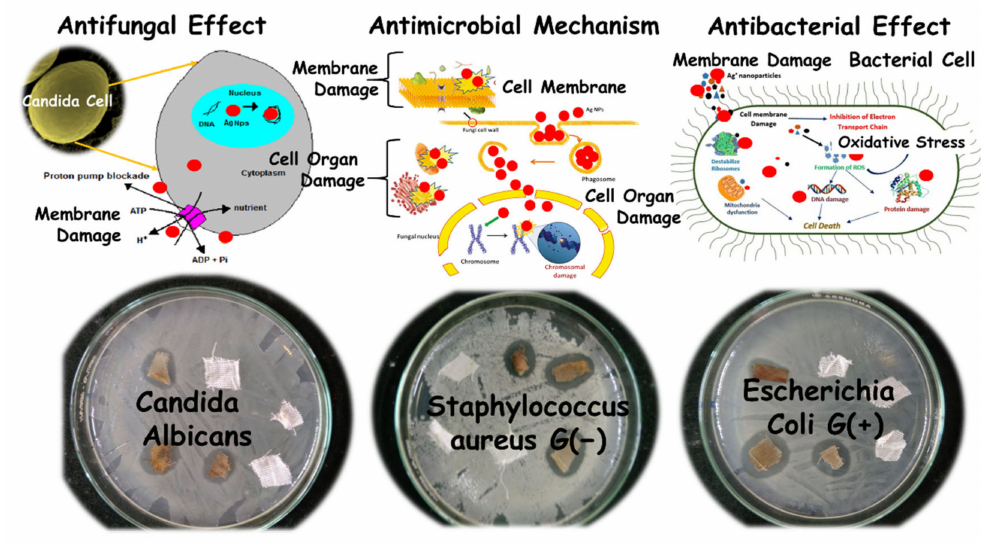
Figure 10. Ag NP antimicrobial effect in Candida albicans , Escherichia coli (G(+)), and Staphylococcus aureus (G( −